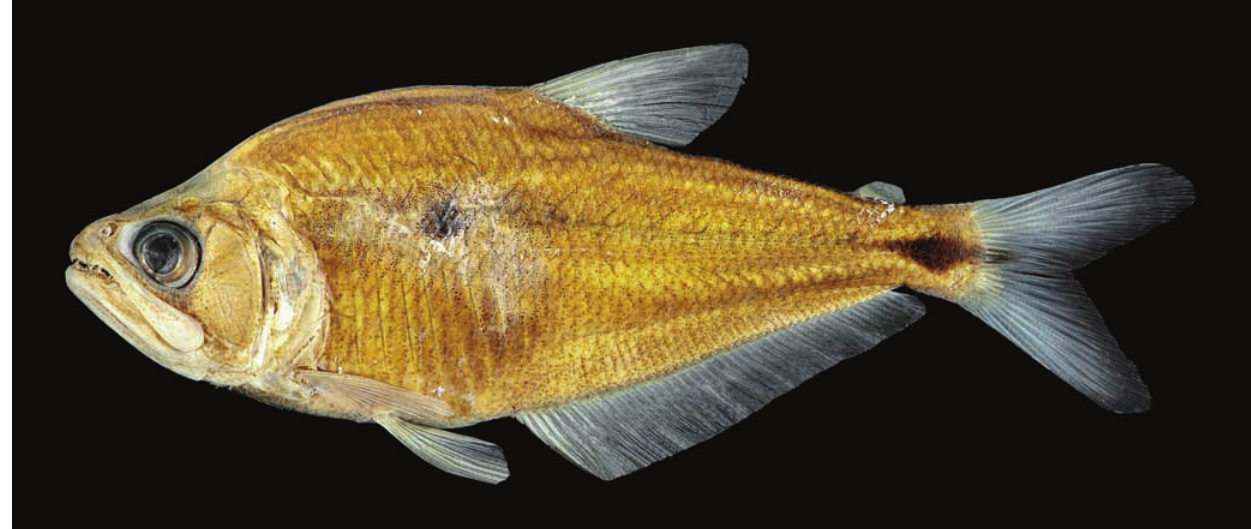
Fig. 16. Charax metae , CAS 69117, 87 mm SL, Colômbia, Meta, Puerto Barrigona (=Barrigón) at head of navigation east of